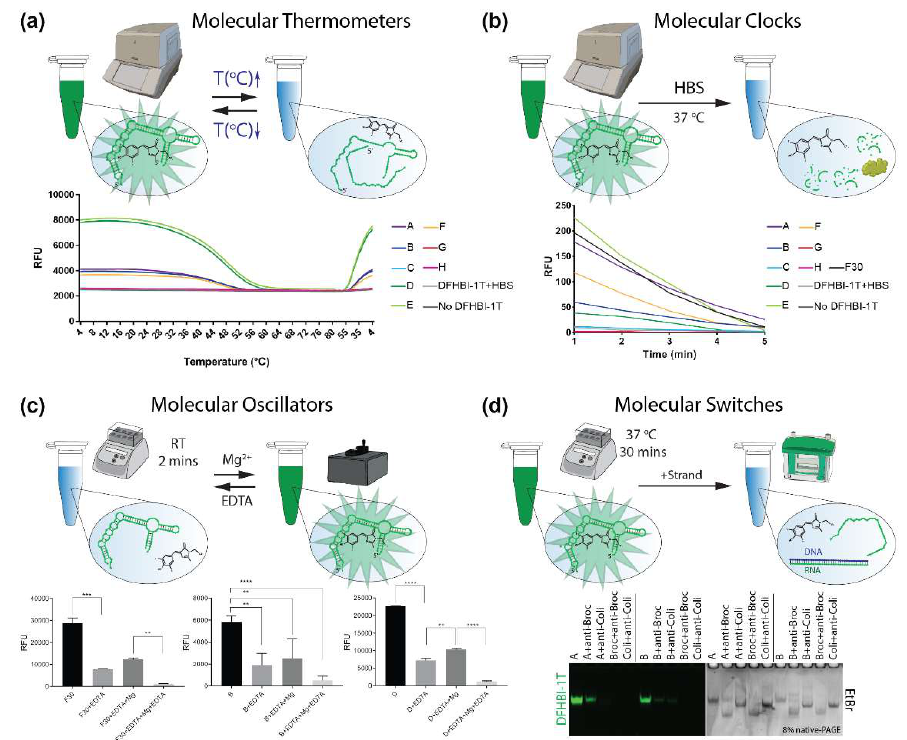
Figure 3. Molecular devices built with fluorets. ( a ) “Molecular Thermometer” that tracks the temperature changes via fluorescence activation and deactivation. ( b ) “Molecular Clock” that can trace the presence of sample in human blood serum via the fluorescence deactivation. ( c ) “Molecular Oscillators” working in response to the presence of magnesium ions. Statistical analysis was performed by one-way ANOVA (** p < 0.01, *** p < 0.001, **** p = 0.0001). ( d ) “Molecular Switches” responding to the introduction of